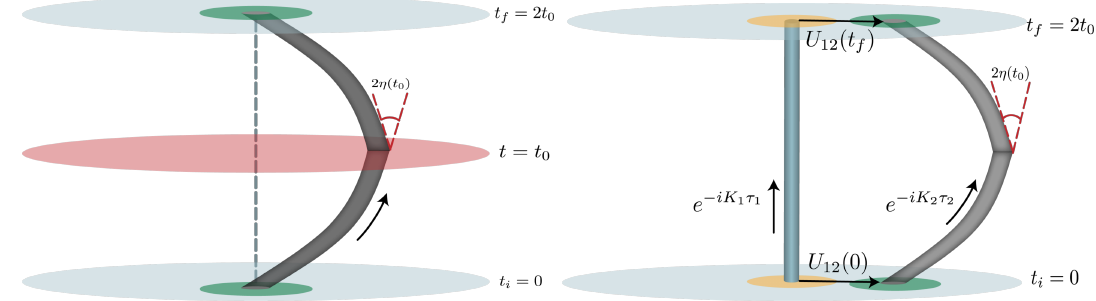
Figure 4. LEFT: a black hole in AdS that receives a kick at t 0 . Arbitrary trajectories in AdS can be generated by a dense sequence of such instantaneous kicks, allowing us to describe proper time evolution in any weakly curved spacetime. RIGHT: twin black holes. The left twin is static while the right twin is the accelerated black hole of the LEFT panel. The time dilation experienced by the twins is computed by the modular Berry holonomy of the “loop” of modular Hamiltonians describing the two trajectories and the integral of the zero mode projection of the CFT Hamiltonian along the loop via eq. (3.28),